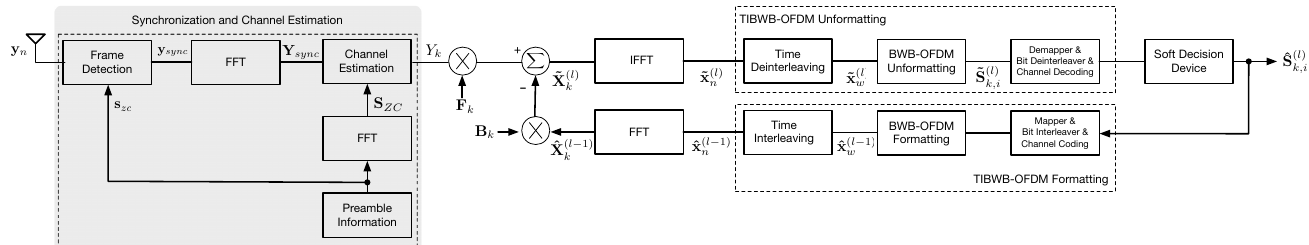
Figure 2. Preamble-assisted TIBWB–OFDM receiver scheme with IB–DFE equalization.